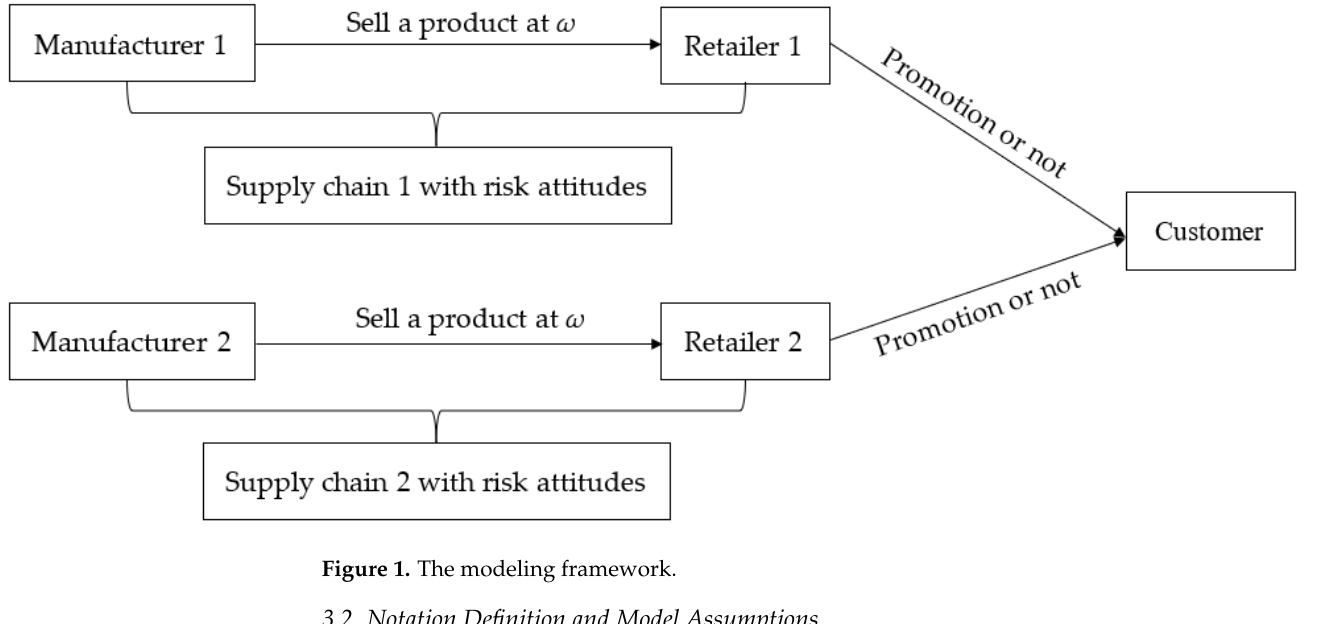
Figure 1. The modeling